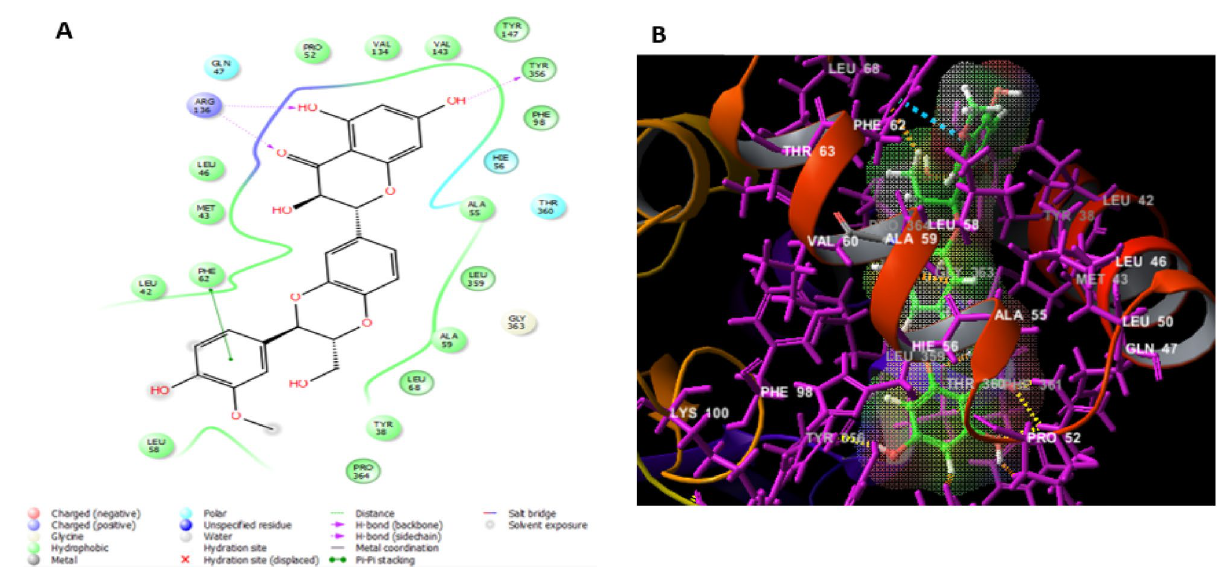
Figure 4. The docked pose of silibinin interacting with the amino acid residues of hDHODH active site in 2D ( A ) and 3D ( B )